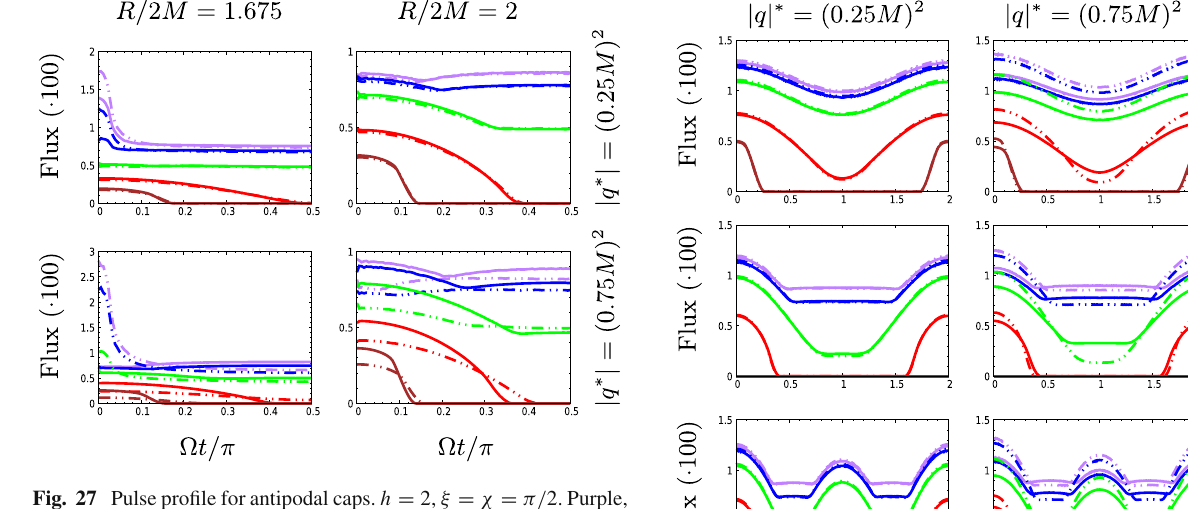
Fig. 27 Pulse profile for antipodal caps. h = 2, ξ = χ = π/ 2. Purple, blue, green, green, red and brown lines correspond to (cid:11) = 0 . 00, 0 . 30, 0 . 60, 0 . 90 and 0 . 99 respectively. The solid lines correspond to q ∗ > 0 while the dashed lines correspond to q ∗ < 0